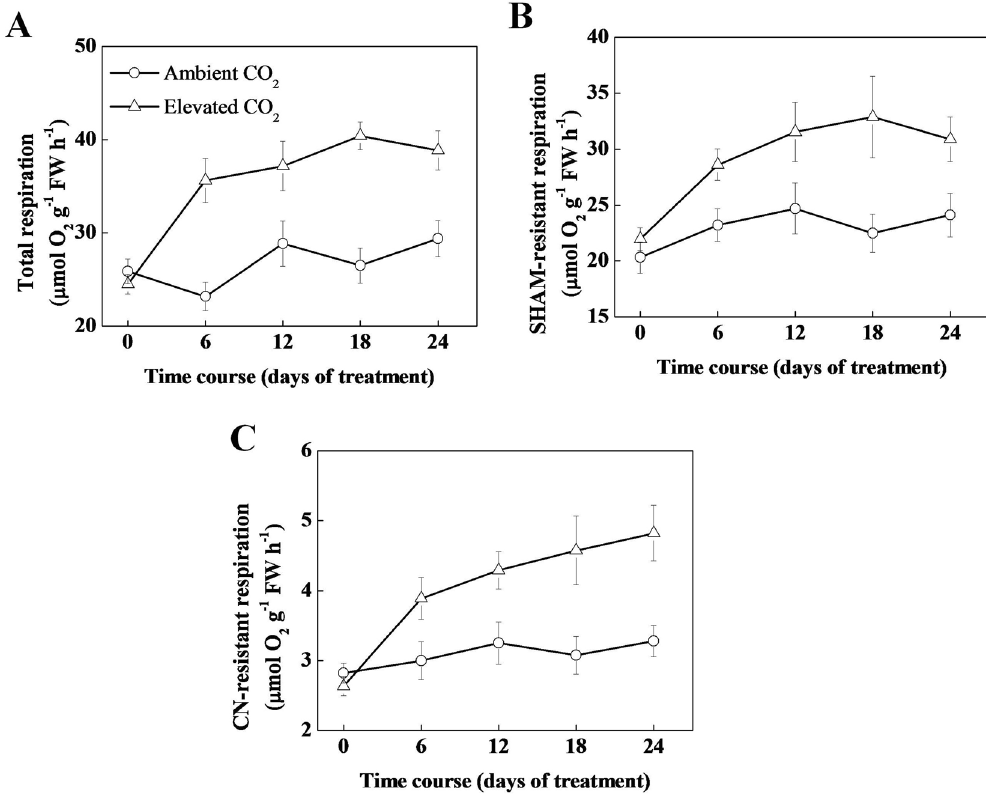
Figure 2. Changes in the O 2 uptake rate of tea seedlings grown at ambient (380 µ mol mol − 1 ) or elevated CO 2 concentration (800 µ mol mol − 1 ). ( A ) Total respiration, ( B ) salicylhydroxamic acid (SHAM)-resistant respiration, ( C ) cyanide (CN)-resistant respiration. Tea seedlings were exposed to either ambient (380 µ mol mol − 1 ) or elevated CO 2 concentration (800 µ mol mol − 1 ) for 24 day. Measurements were taken at different time- points as mentioned in the respective figures. The results are expressed as the mean values ± SD, n =